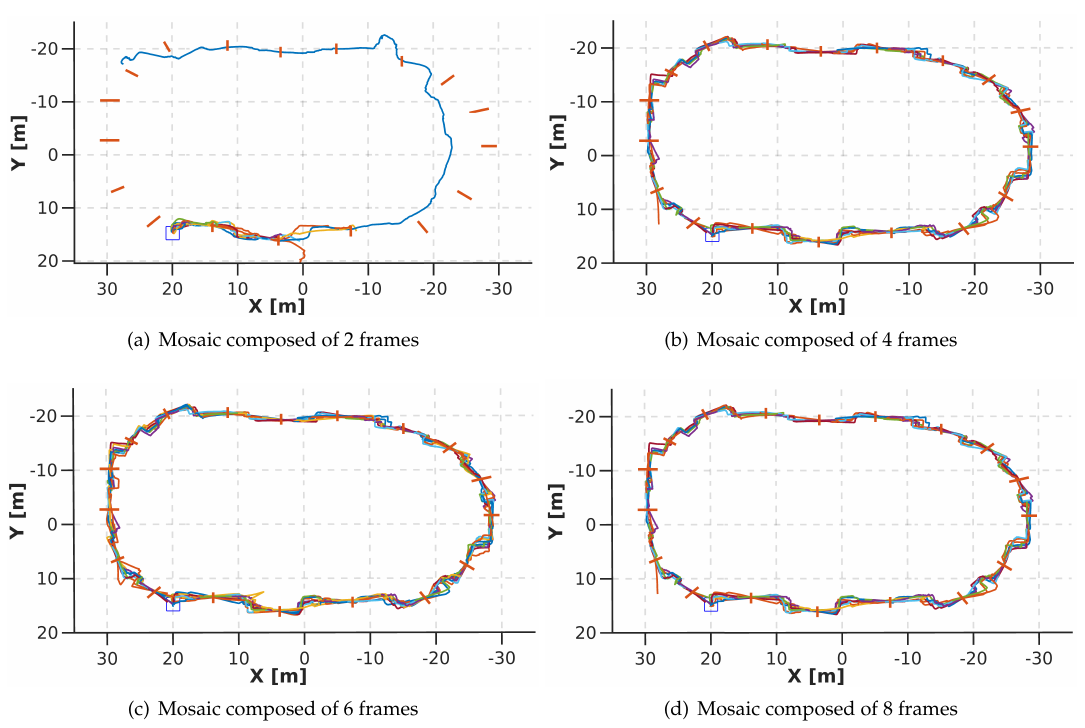
Figure 20. Top view of 10 runs performed on the track shown in Figure 19. Each sub-image shows the DeepPilot’s performance when using a mosaic image composed of: ( a ) 2 frames; ( b ) 4 frames; ( c ) 6 frames; ( d ) 8 frames. Note that ( c , d ) are successful and similar in performance. Figure 20b corresponds to the training using a mosaic image, composed of 4 frames, as